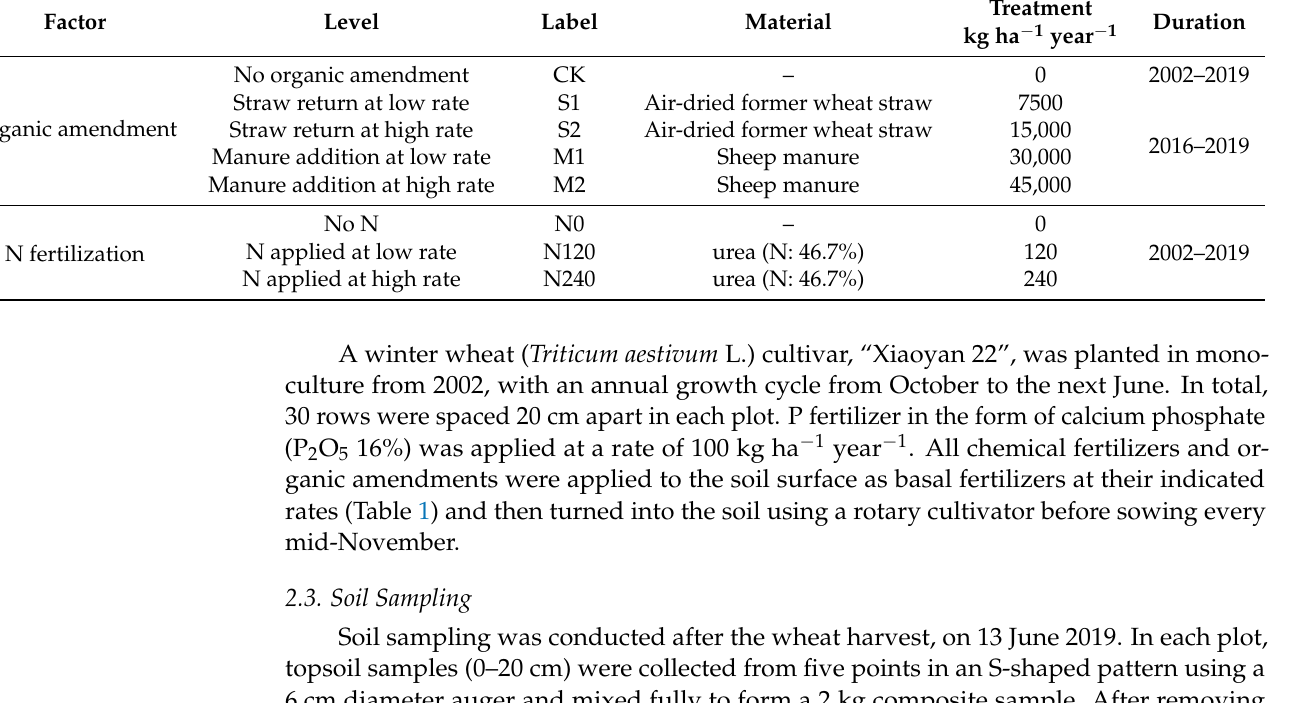
Table 1. Experimental design of the study in the loess soil agroecosystem over a 17-year period. Factor Level